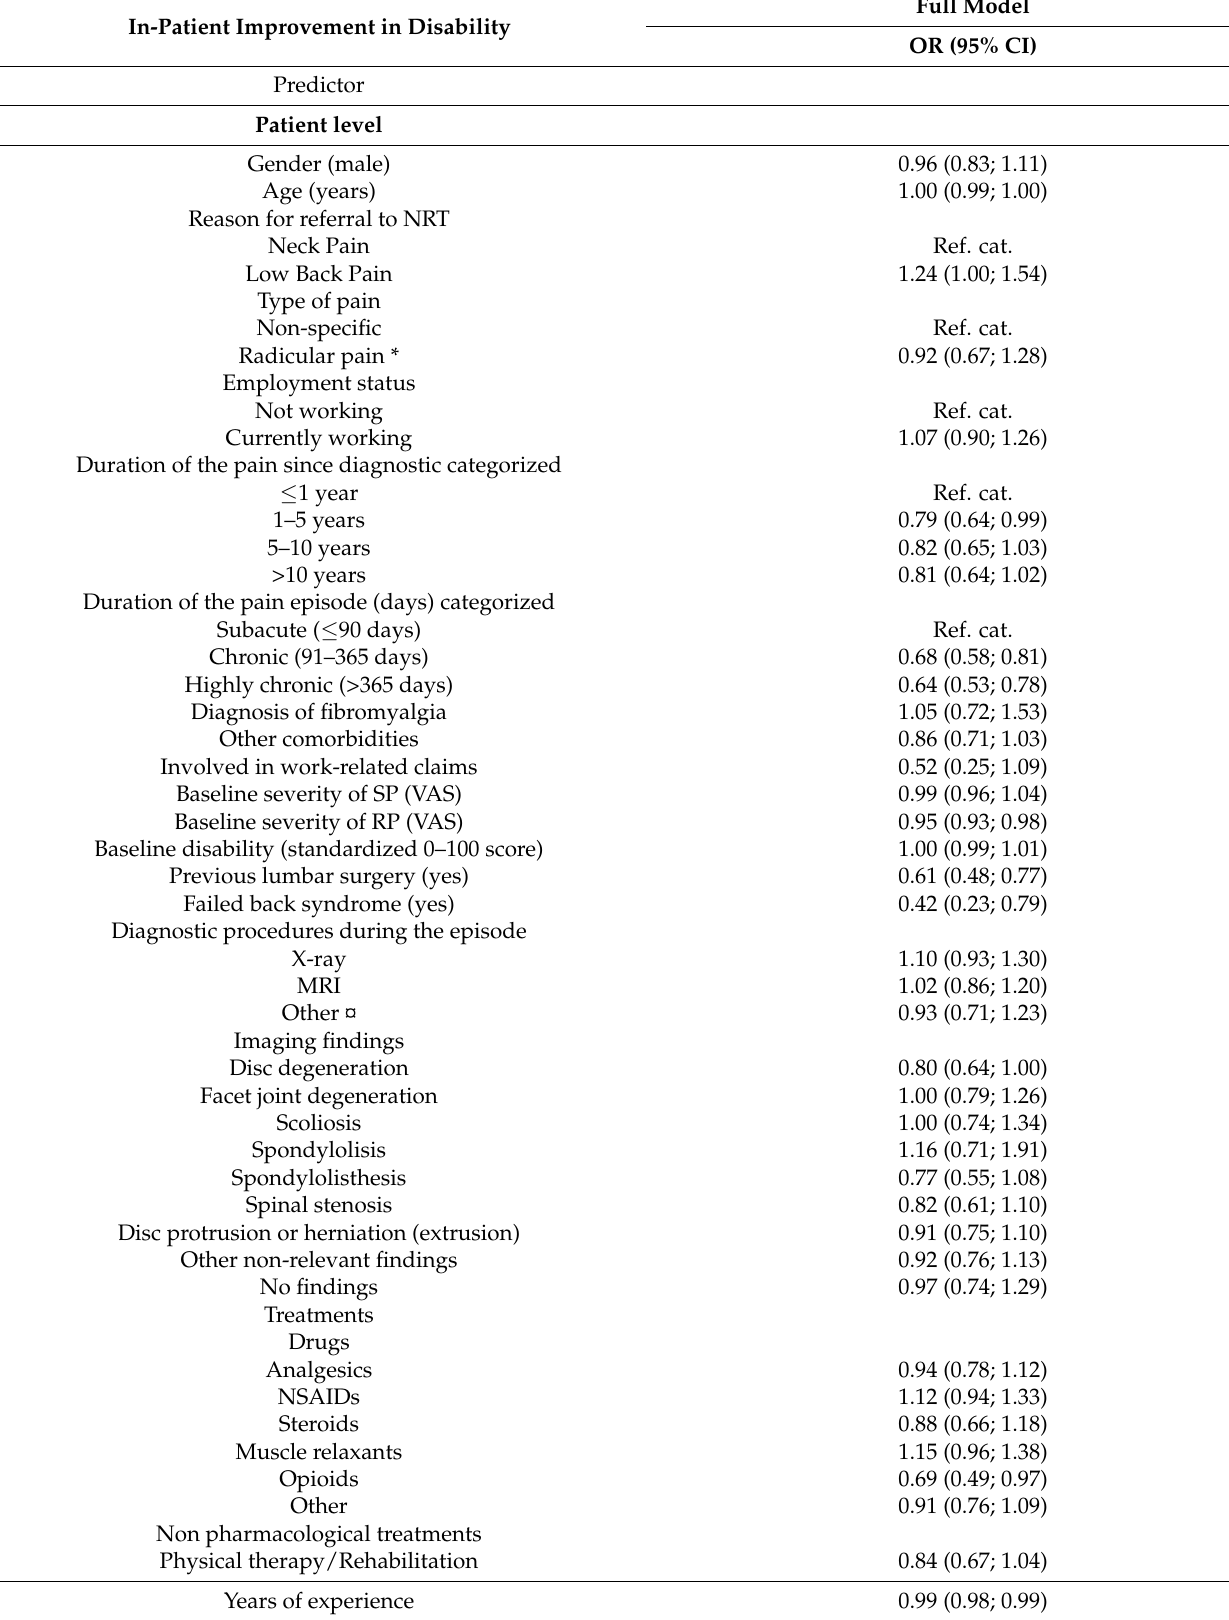
Table 8. Multilevel full model to determine the strength of the association between predictors and improvement in disability ( n =